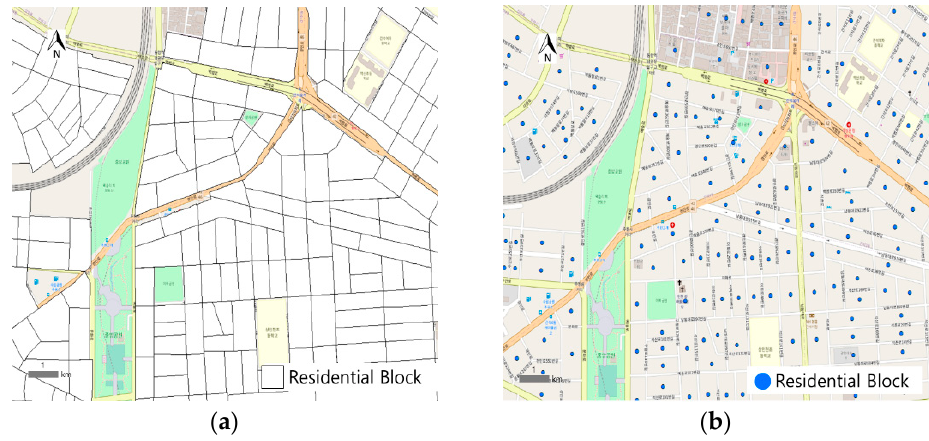
Figure 2. RBs in Namdong-gu, Incheon: ( a ) residential blocks in polygon features; ( b ) residential blocks in point features.